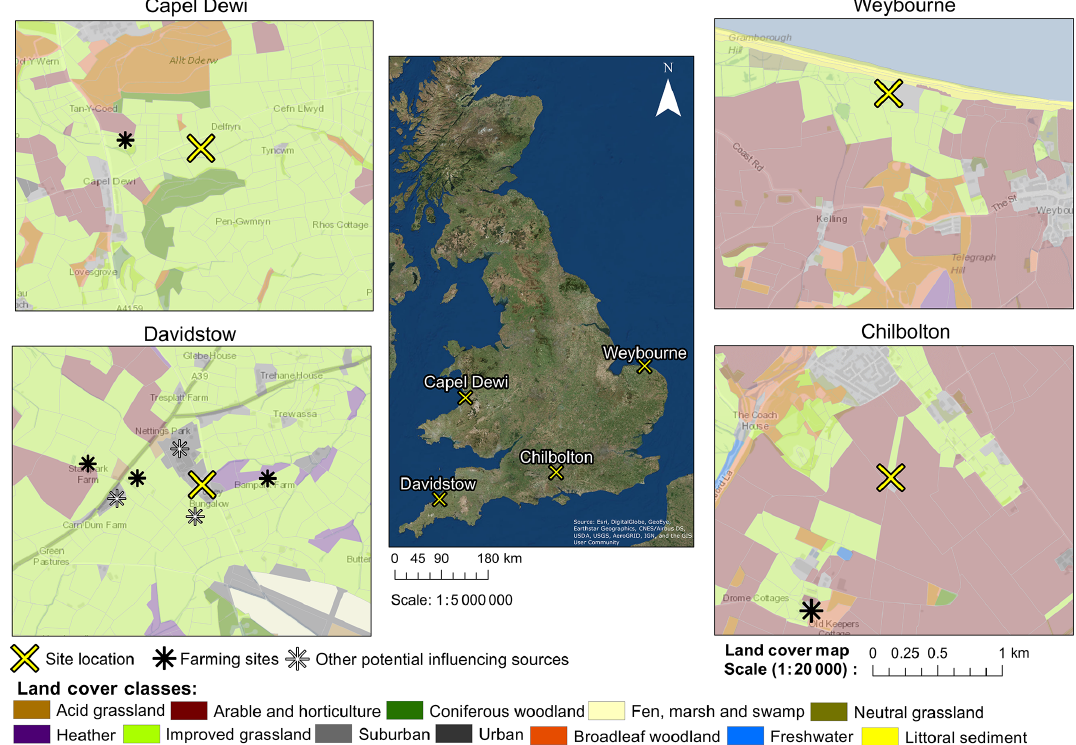
Figure 1. Land cover maps at each site produced using the Centre for Ecology and Hydrology Land Cover Map 2015, OS data (© Crown Copyright and database right 2018), and the World Imagery ArcMap Layer in ArcGIS version